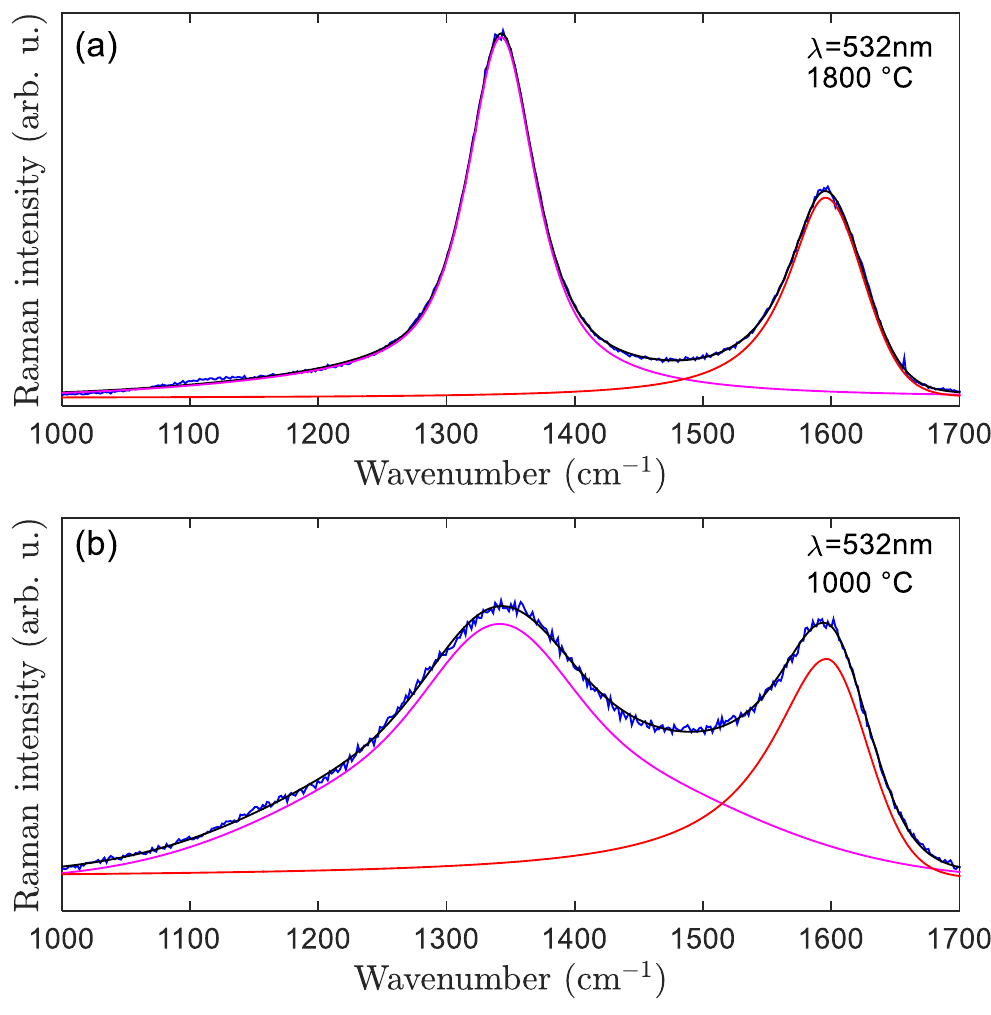
Figure 5. Raman spectra of cellulose carbonized at ( a ) 1800 and ( b ) 1000 ◦ C obtained with an excitation wavelength of 532 nm and fitted with two bands. The magenta lines in both spectra are the result from the fitting of the D band with two components D s and D b , as described in Section 2.4.1. Fitting with two bands, as shown in Figure 5, helps to obtain the intensity of the G and D bands, as well as the full-width at half maximum of the D band ( FWHM D ). Table 4 lists the average L a of the crystallites in both cellulose chars calculated from the D and G bands, following the various ways described in Section 2.4. The values obtained from the intensity ratio I D / I G are in the order of 1.42 and 2.45 nm at 1000 and 1800 ◦ C, respectively, whereas the L a values derived from the confinement model using FWHM D are much higher with a factor of 2 and 3.5, respectively. Table 4. L a obtained using the 532 nm excitation